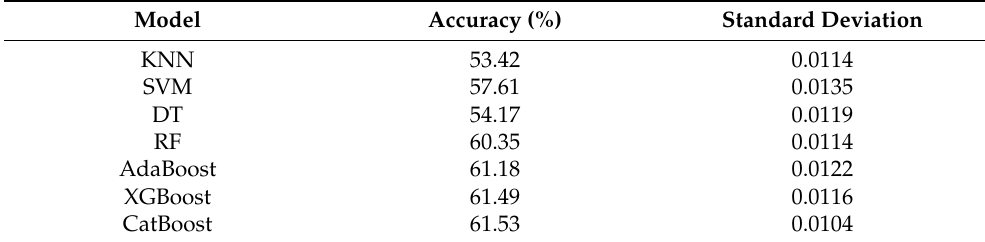
Table 2. Performance metrics of the models for training.